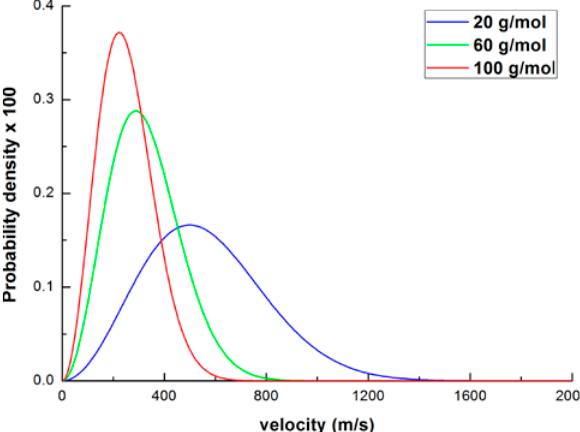
Figure 1. Maxwell-Boltzmann probability distribution of atomic velocities (see Eq. 4) at the temperatures specified in the legend for a set of 200 atoms of mass m = 20 g/mol. The MD time step was 1